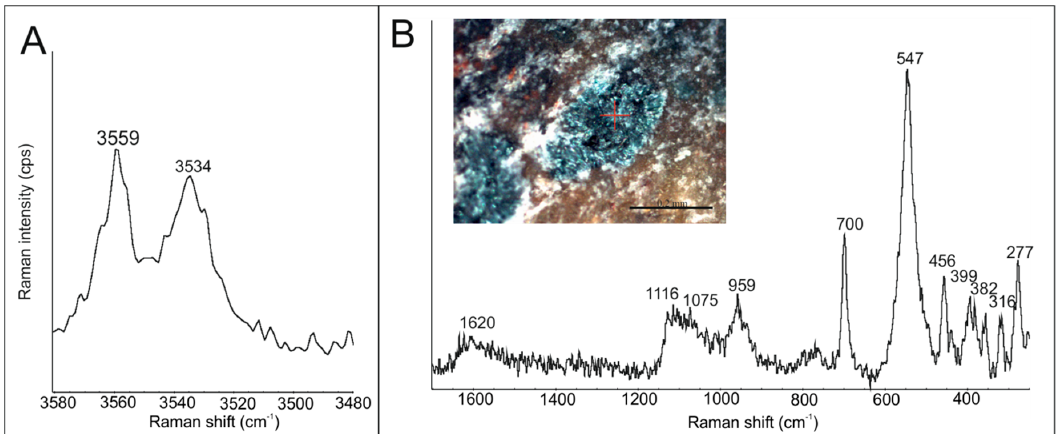
Figure 7. Microphotograph and Raman spectra of celadonite in the range of 3580–3480 cm − 1 ( A ) and 1700–250 cm − 1 ( B ). Analytical spot was marked by red cross.